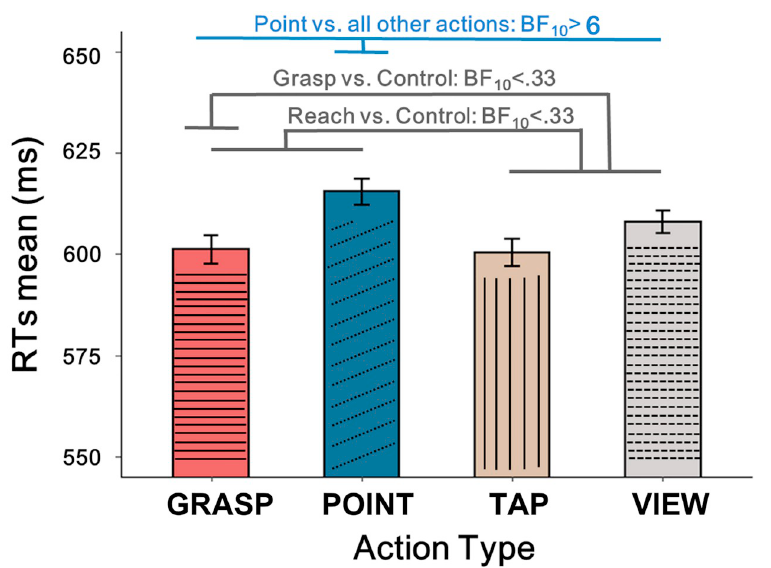
Fig 2. Effects of action type. Preregistered planned comparisons and the related results are reported in grey (grasp vs. control conditions; reach vs. control conditions), while additional planned comparisons and the related results are reported in blue. Error bars represent within-subjects SEM, computed only for illustration purposes